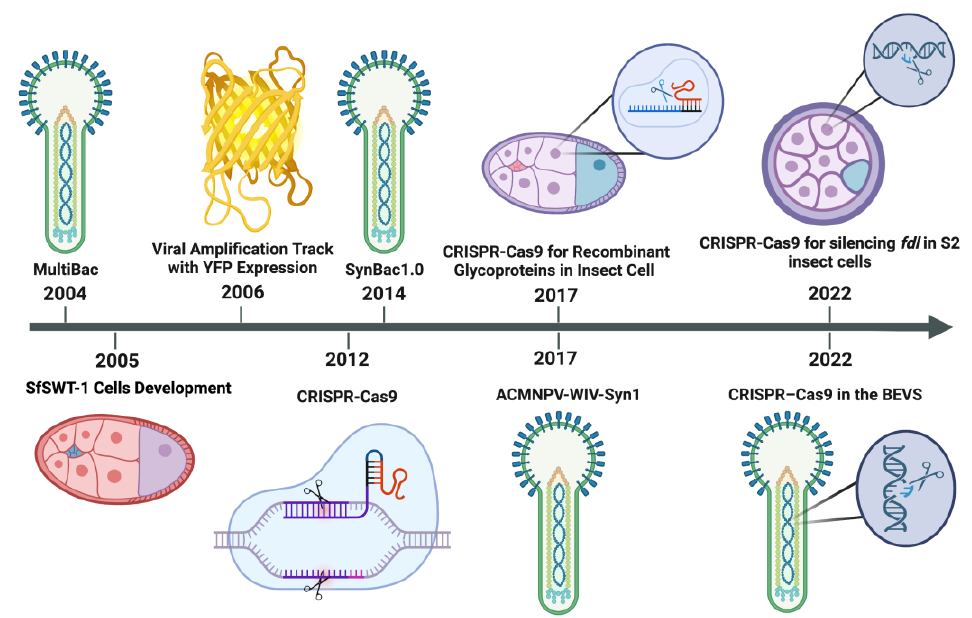
Figure 1. Evolution of Baculovirus expression vector system (BEVS), MultiBac technology and CRISPR/Cas9 system. MultiBac has made it simple to access baculoviral genomes ever since it was first used, in addition to the incorporation of CRISPR components on both natural and synthetic insect cells, and minimized genomes (SynBac). fdl: fused lobes gene; SfSWT-1: commercial transgenic insect cell line called mimic Sf9; YFP: Yellow Fluorescent Protein .